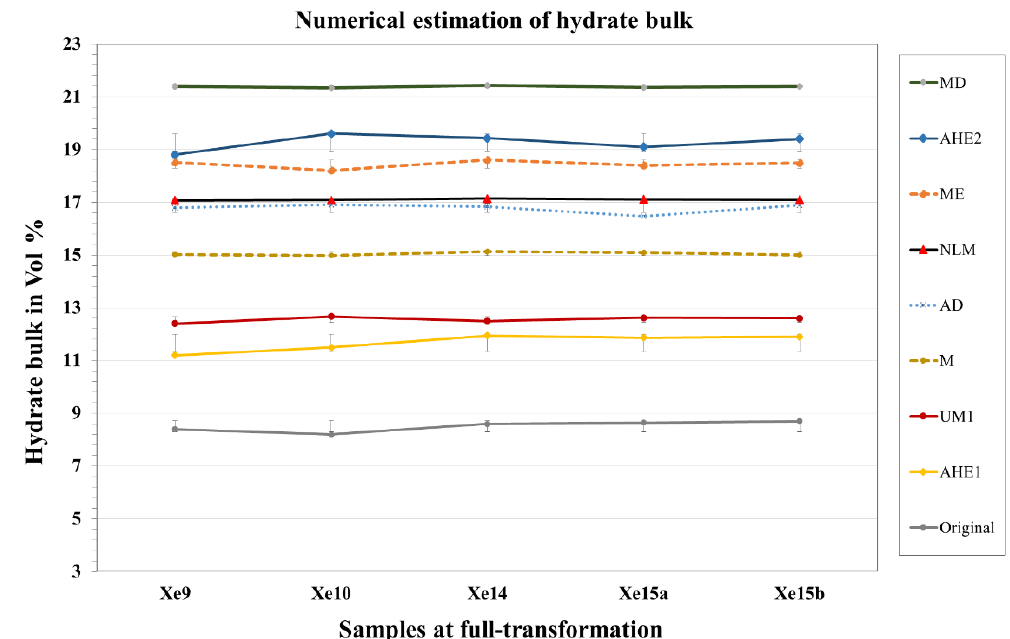
Figure 6. Diagram of the results obtained from numerical estimation of the hydrate content in five different samples containing approx. 17% controlled by the water available at the initial formation stage.